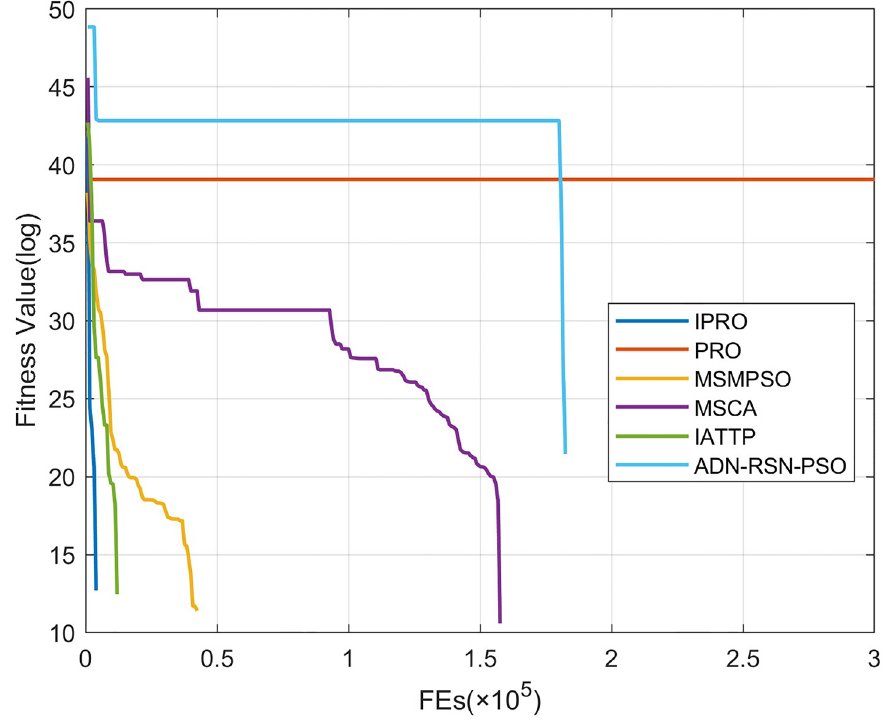
Fig 3. Convergence curves on F3.